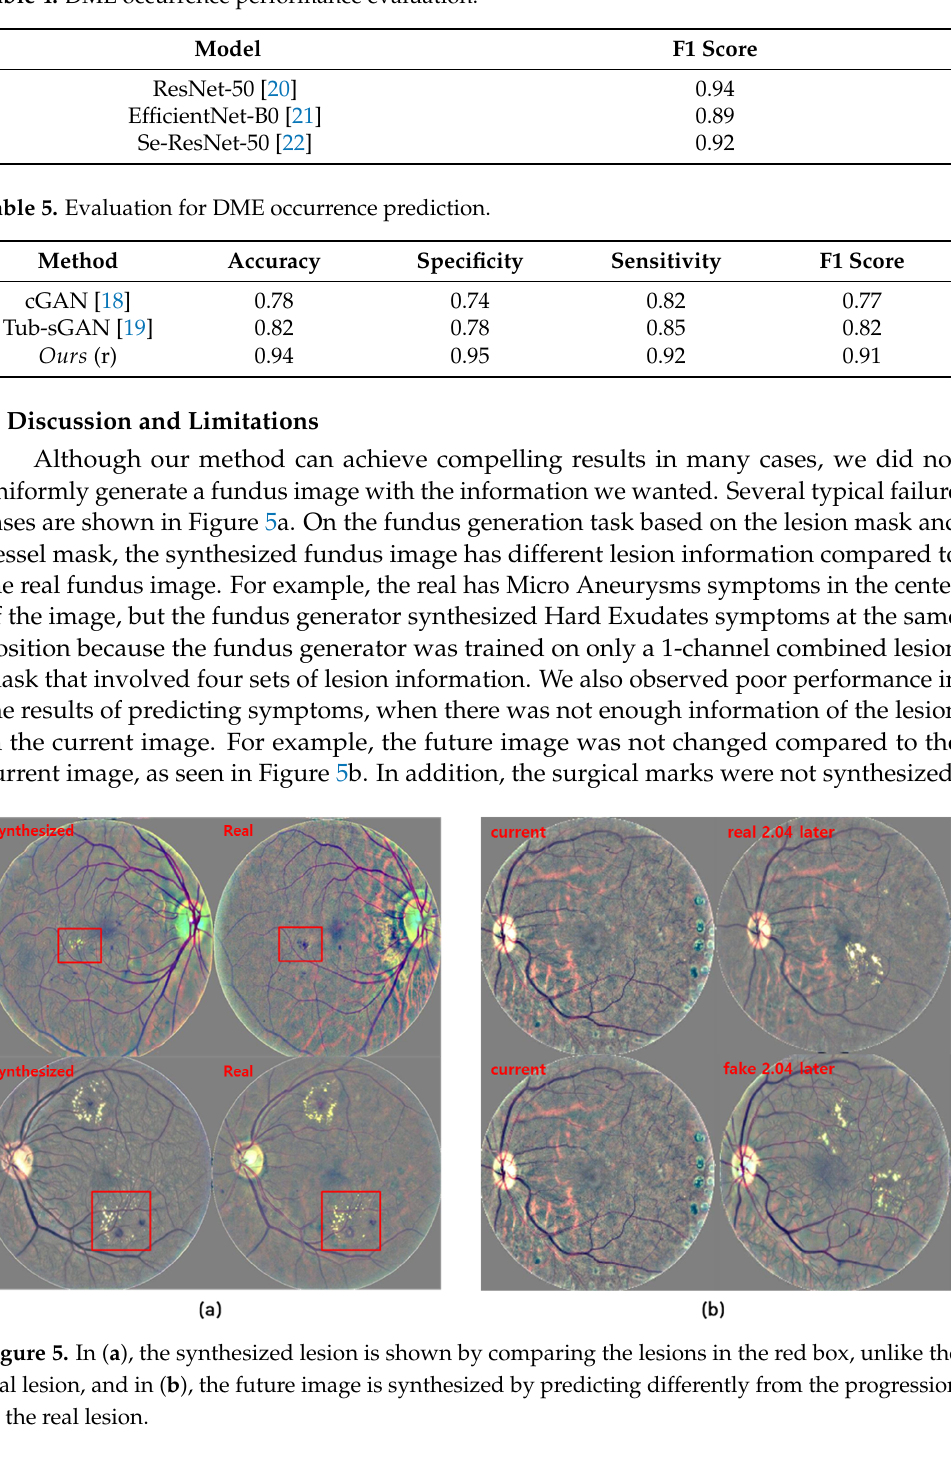
Table 4. DME occurrence performance evaluation.